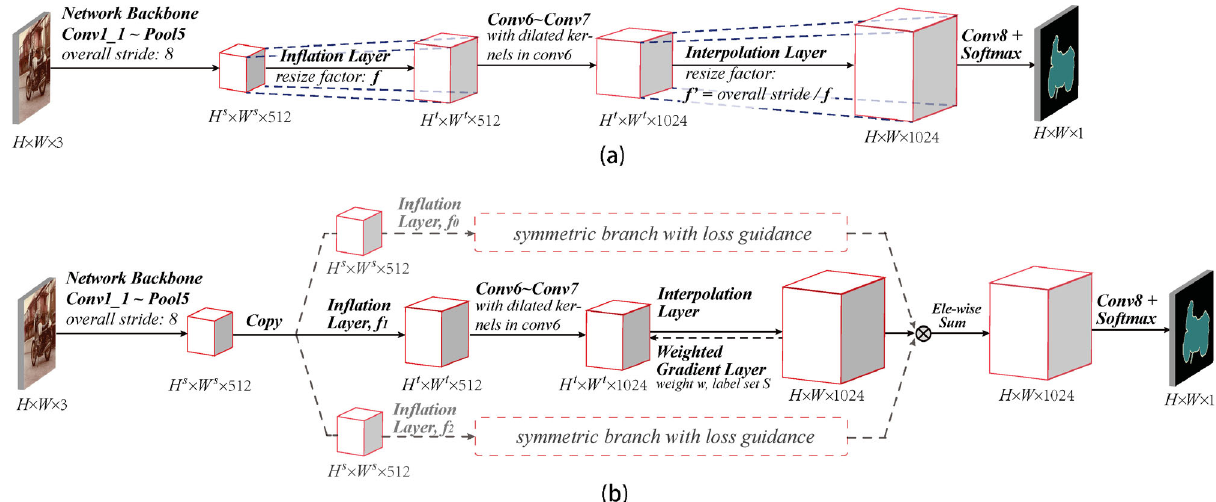
Fig. 1 Framework. (a) Modified single-path network. New layers are inserted before layer fc6 and after layer fc8. (b) Modified multi-path network in which all branches have the same structure and initialization. Weighted gradient layers are used to break symmetry during training. The specific settings for the single-path network are given in Table